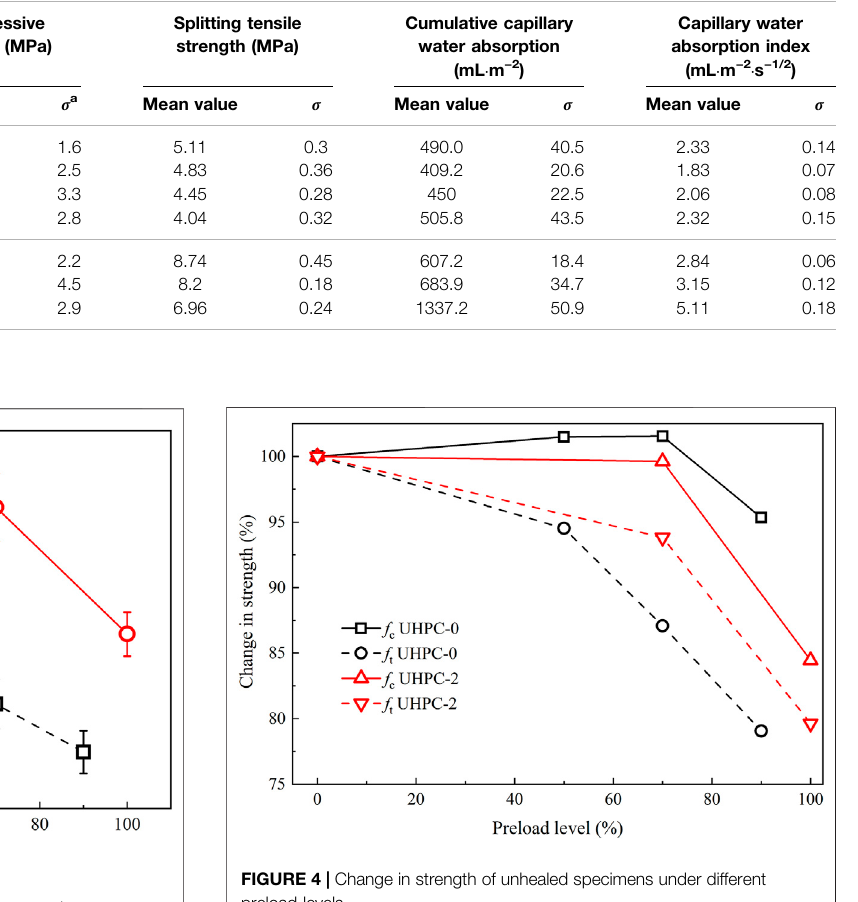
FIGURE 2 | Compressive strength of unhealed specimens under different preload levels.